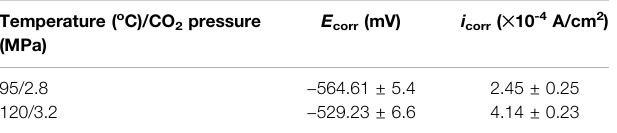
TABLE 1 | Fitting electrochemical parameter of the potentiodynamic polarization curvesofHP-13CrSSafterLAimmersionintheFWat95 ° C/2.8 MPaCO 2 and 120 ° C/3.2 MPa CO 2 .